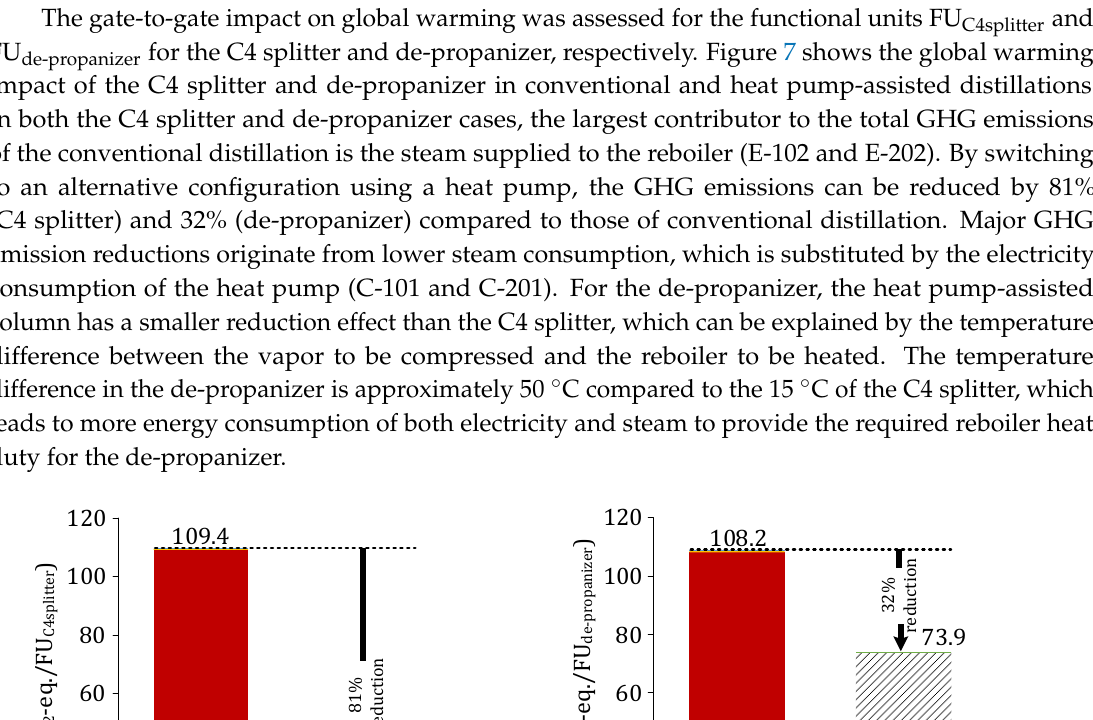
Figure 6. Sensitivity of the total annual cost and payback time to economic parameters: ( a ) and ( b ) Heat pump-assisted C4 splitter and ( c ) and ( d ) heat pump-assisted de-propanizer. The numbers represent the total annual cost variation (%) or payback time variation (%) due to a 1% change in a parameter.